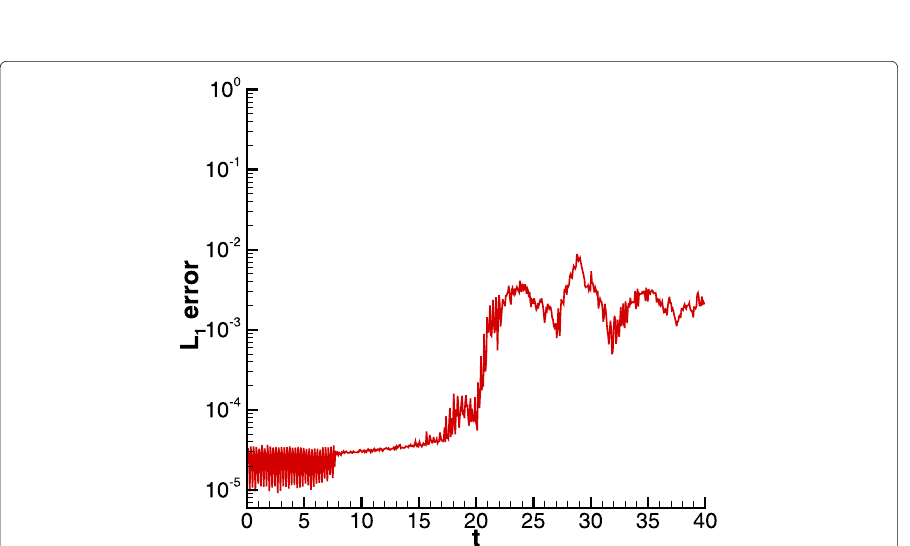
Fig. 9 Example 8. Time history of L 1 error of the divergence of the velocity ∇ ·